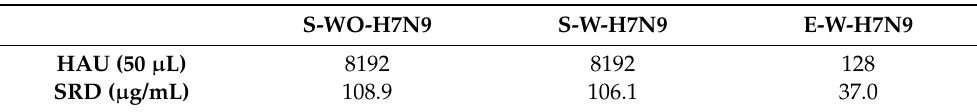
Table 1. The results of hemagglutination activity and single radial immunodiffusion assays in different vaccine